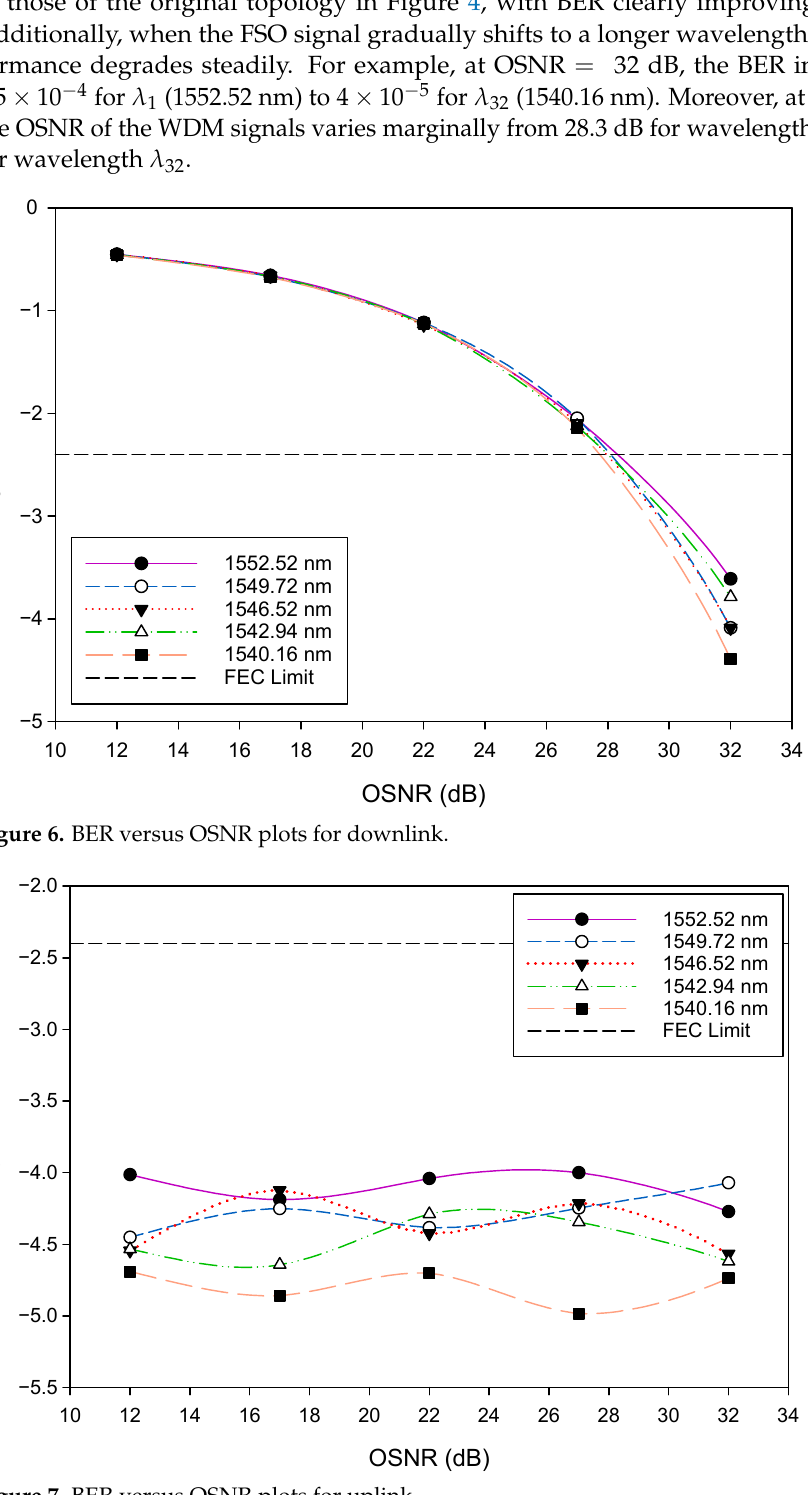
Figure 7. BER versus OSNR plots for